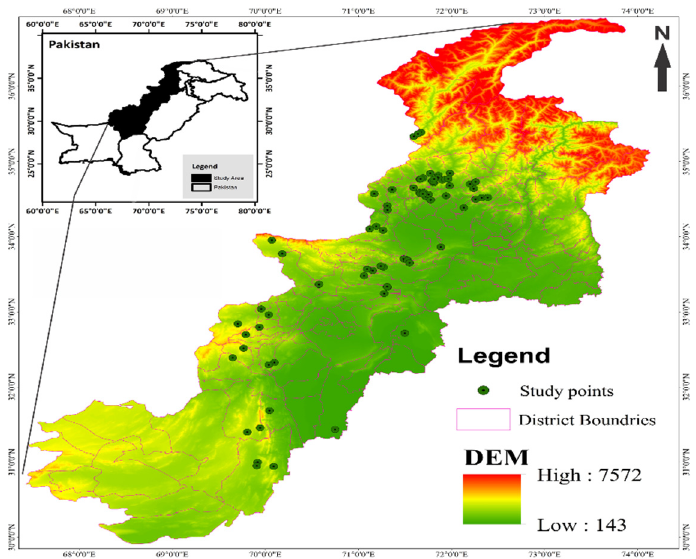
Figure 2. Distribution of Monotheca -dominated phytocoenoses in different elevation ranges across Pakistan.